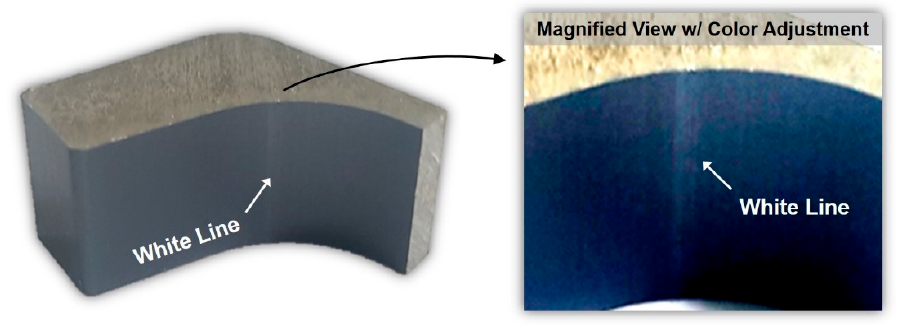
Figure 16. White line defect after anodizing treatment of the scaled-up L-shaped sample.